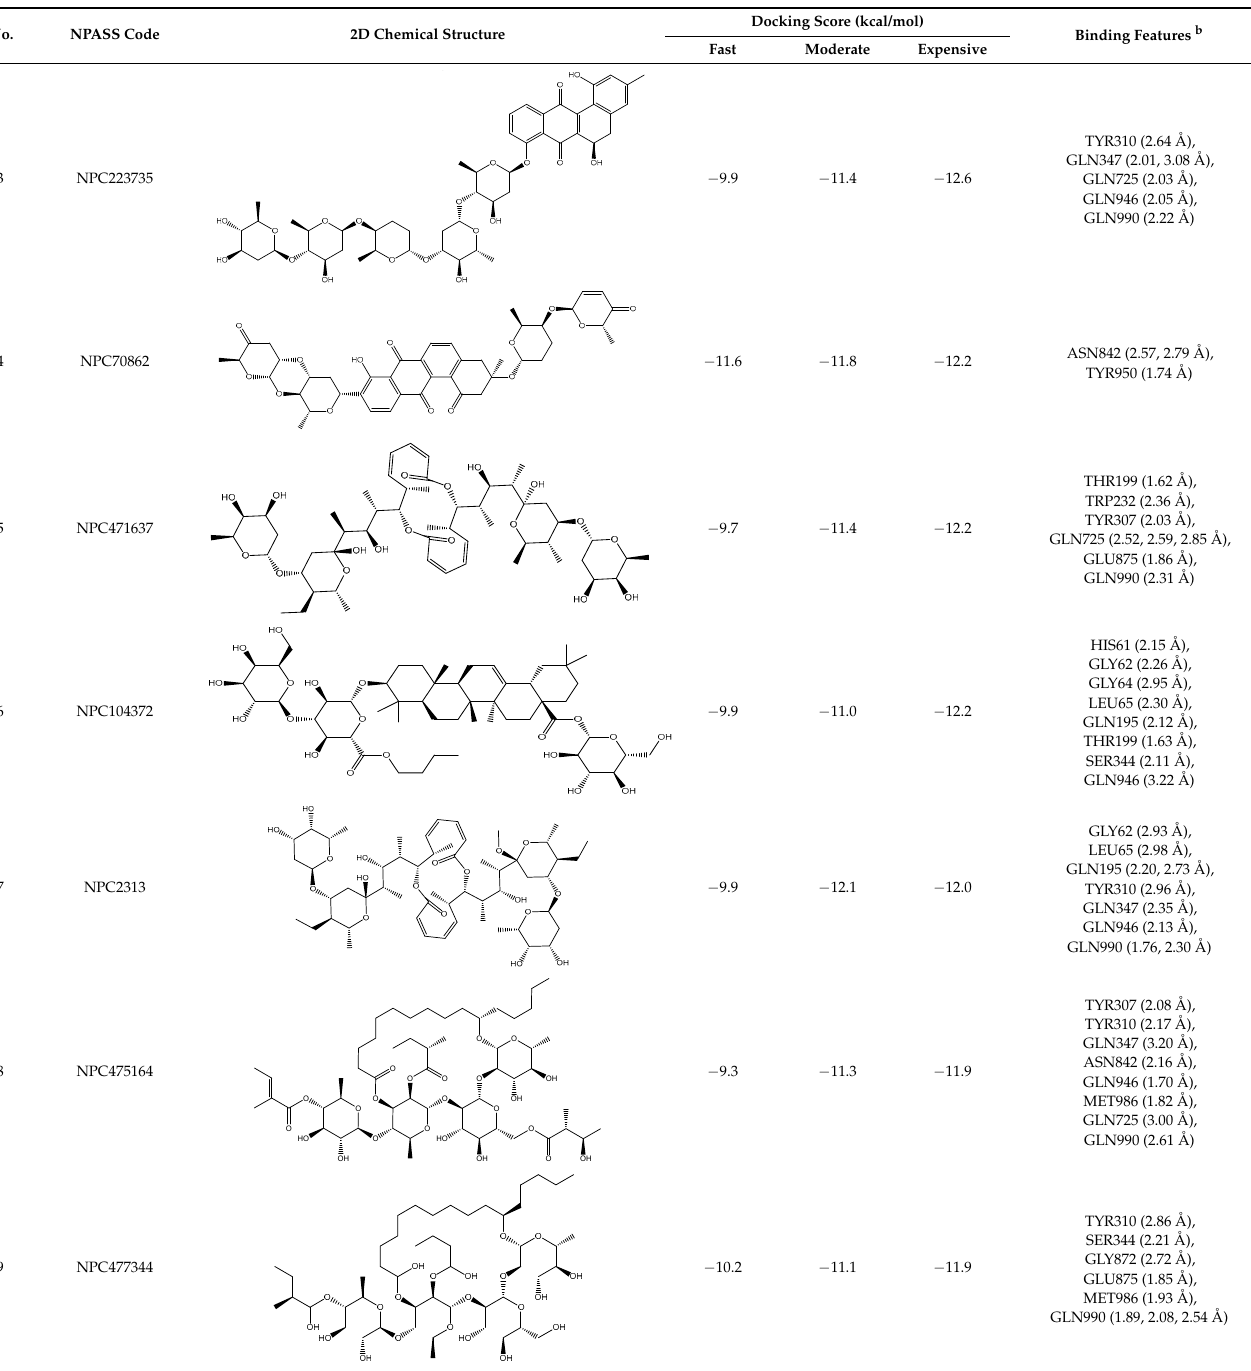
a Data sorted according to the computed expensive molecular docking. b Conventional hydrogen bond only (in Å) is listed .